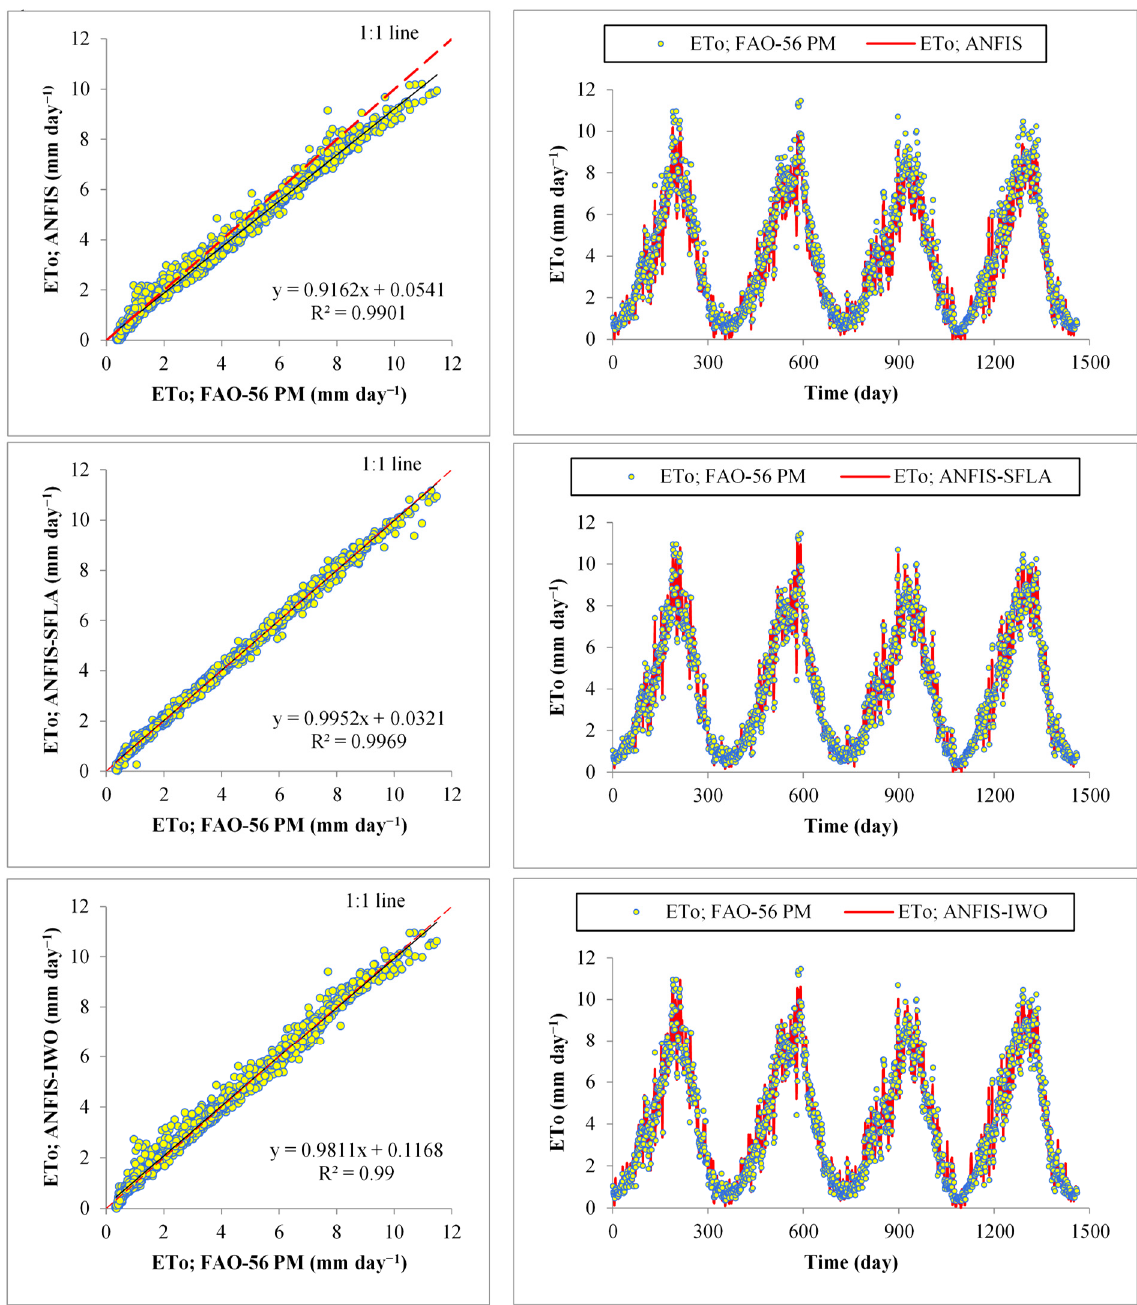
Figure 5. Scatter and time series plots of the daily values of FAO-56 PM ETo vs. modeled data by the best hybrid models and the corresponding classical model (i.e., M7 models) during the test phase (Tabriz station).